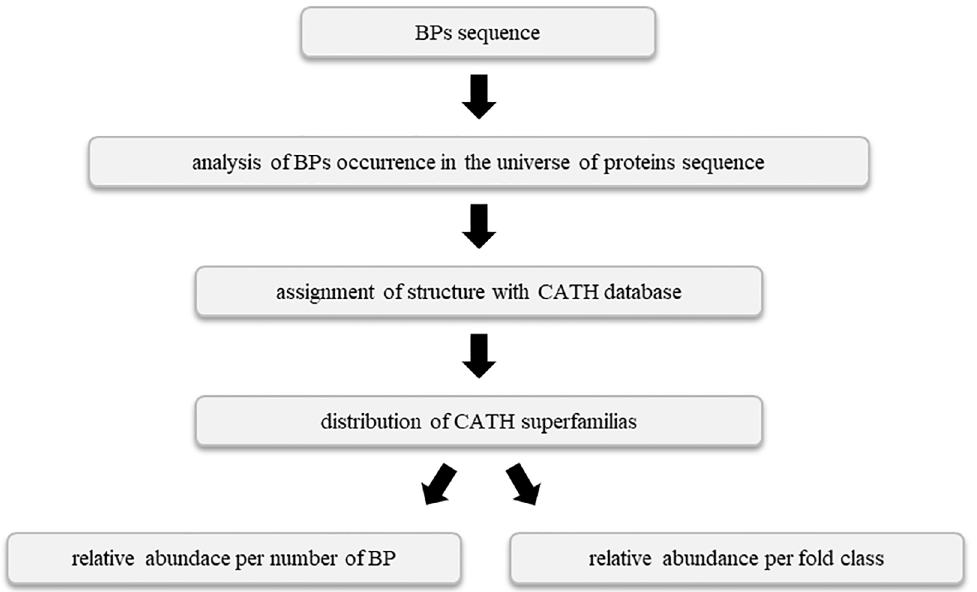
Fig 2. Flowchart of main procedure followed to mapping the structural occurrence of biopeptides.